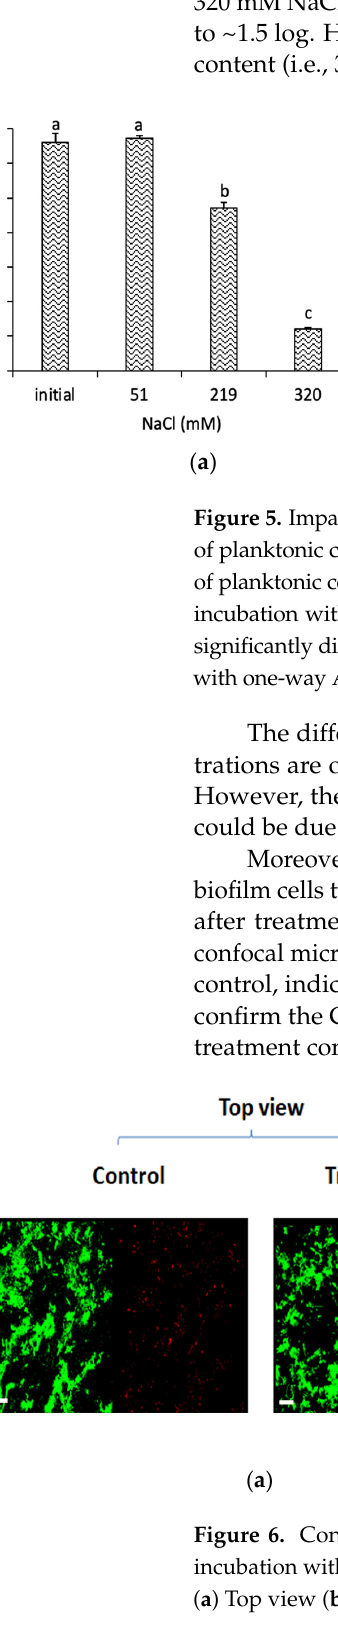
( a ) Top view ( b ) side view. Scale bar: 20 µ